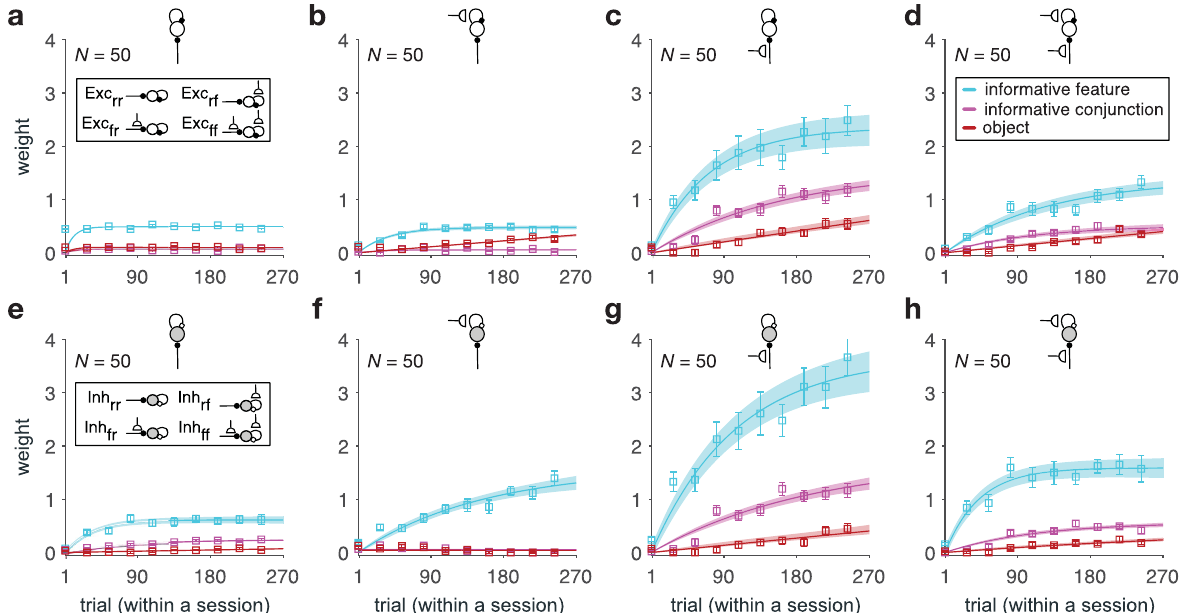
Fig. 6 Response of different types of recurrent populations show differential degrees of similarity to reward probabilities based on different learning strategies. a – d Plotted are the estimated weights for predicting the response dissimilarity matrix of different types of recurrent populations (indicated by the inset diagrams explained in Fig. 4b) using the dissimilarity of reward probabilities based on the informative feature, informative conjunction, and object (stimulus identity). Error bars represent s.e.m. The solid line is the average of fi tted exponential functions to RNNs ’ data, and the shaded areas indicate ±s.e.m. of the fi t. e – h Same as a – d but for inhibitory recurrent populations. Dissimilarity of reward probabilities of the informative feature can better predict dissimilarity of response in inhibitory populations, whereas dissimilarity of reward probabilities of the objects can better predict dissimilarity of response in excitatory populations. Source data are provided as a Source Data fi